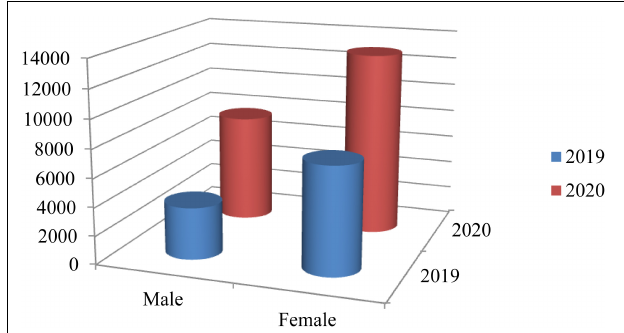
FIGURE 3 | Participants.